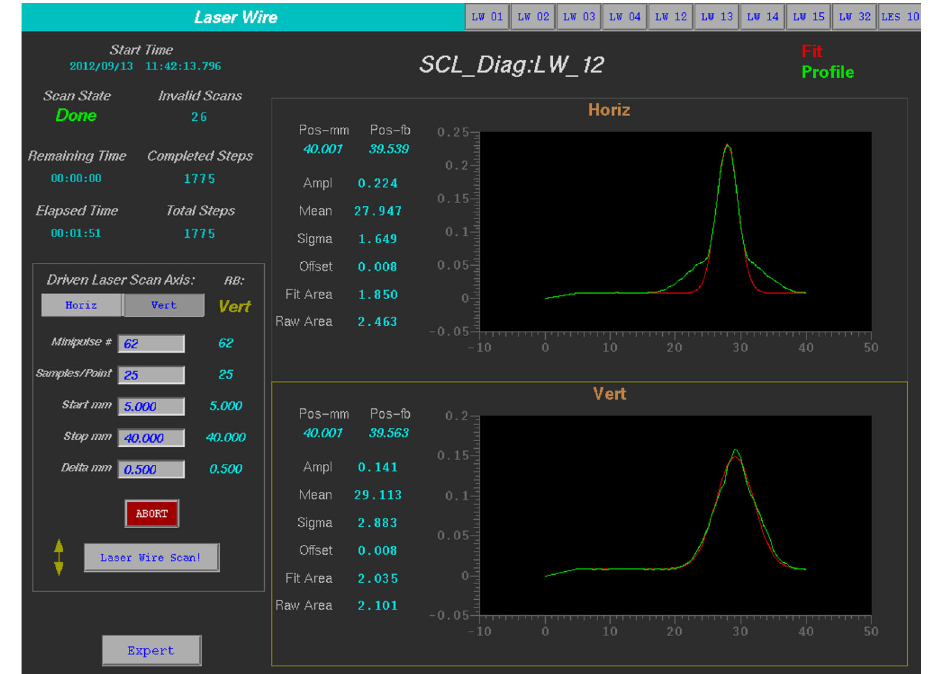
FIG. 6. An example of EDM screen of an individual measurement station (at CM 12 of SCL). The unit of the profile axes is [mm]. The top menu shows all available measurement stations. A new window will be opened when a different measurement station is selected. LES10 is the HEBT laser emittance measurement system which measures the transverse emittance of the ion beam using the same light source [9].